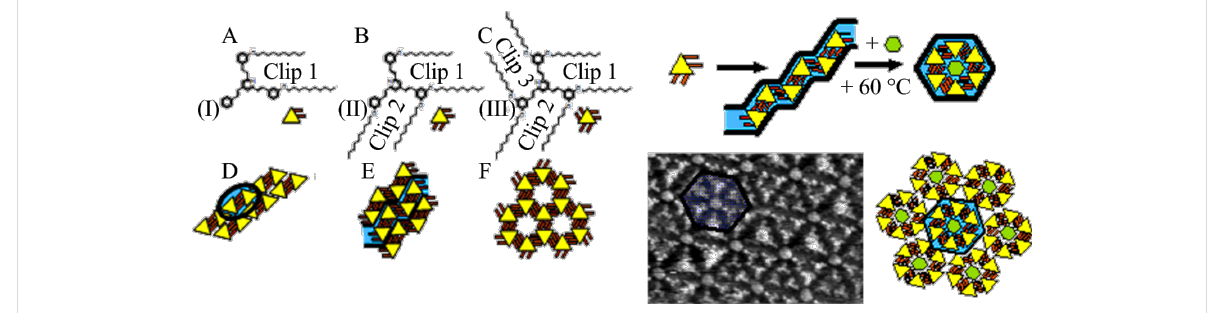
Figure 2: “On demand” realization of dimer-, polymer- or network-like topologies from a given rigid core and clips placed at different locations. Mo- lecular structures of molecules I, II, and III (A–C), along with the anticipated self-assembly (D–F). Figure adapted with permission from [26], copyright 2007 Wiley-VCH Verlag GmbH &